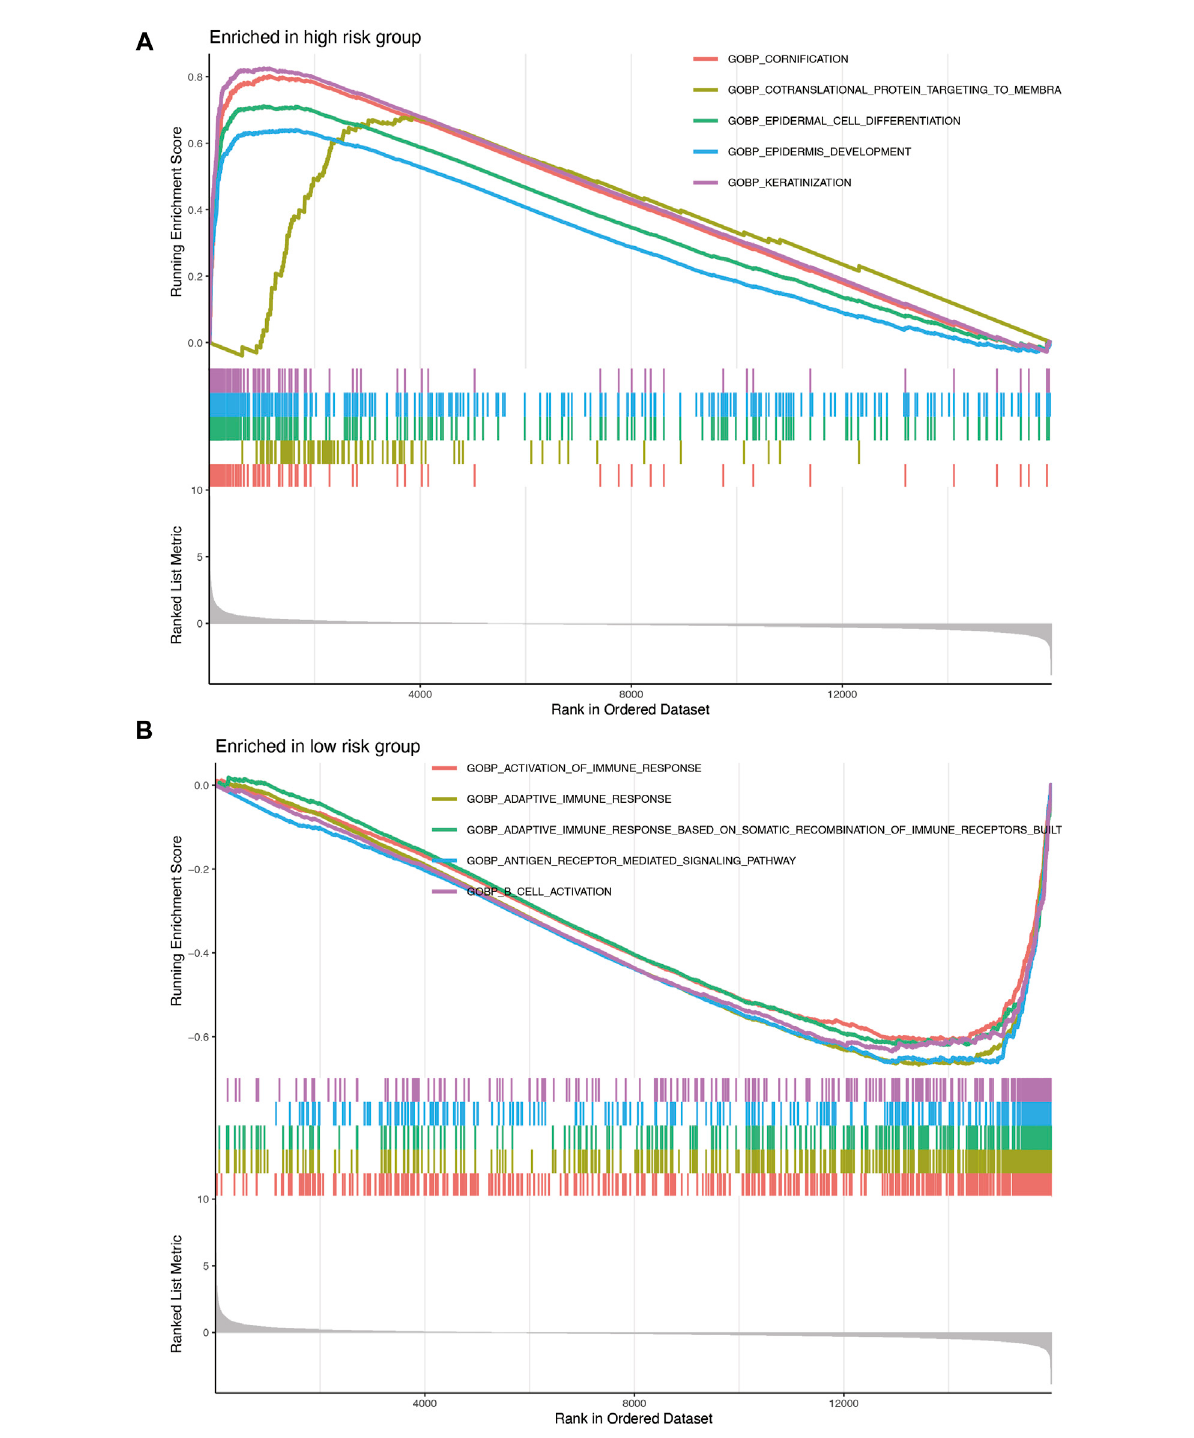
FIGURE 7 (A) Enrichment plots showing epidermis development (blue), epidermal cell differentiation (green), corni fi cation (red), and keratinization (purple) gene enrichment in the high-risk group. (B) Enrichment plots showing the activation of immune response (red), adaptive immune response (orange), adaptive immune response based on somatic recombination of immune receptors built (green), B-cell activation (purple), and antigen receptor-mediated signaling pathway (blue) enrichment in the low-risk